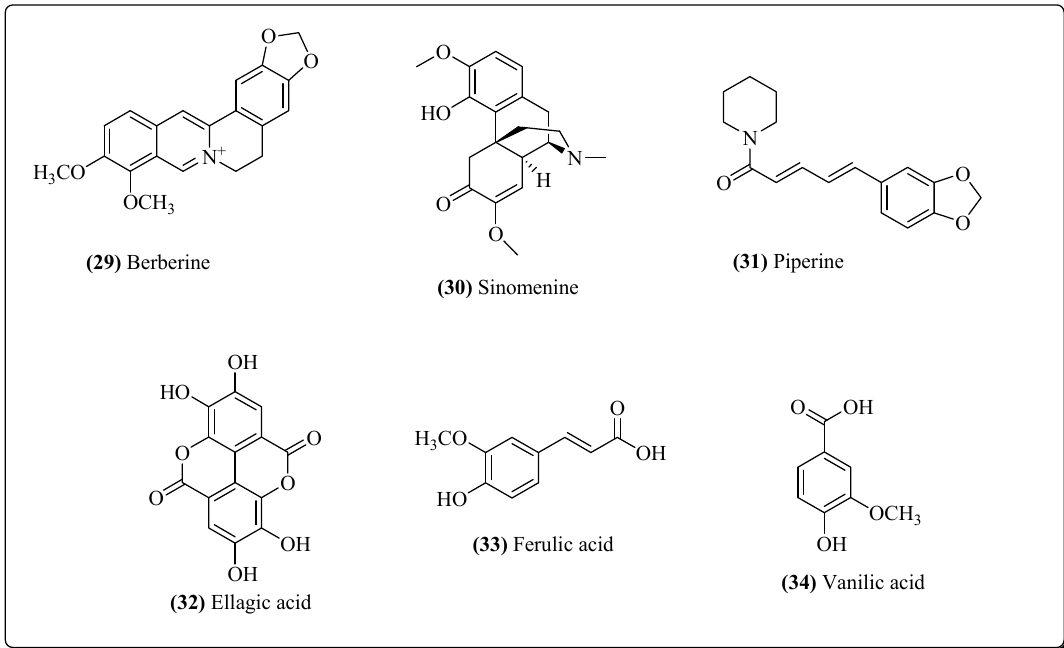
Figure 8. Plant-based Immunomodulators.